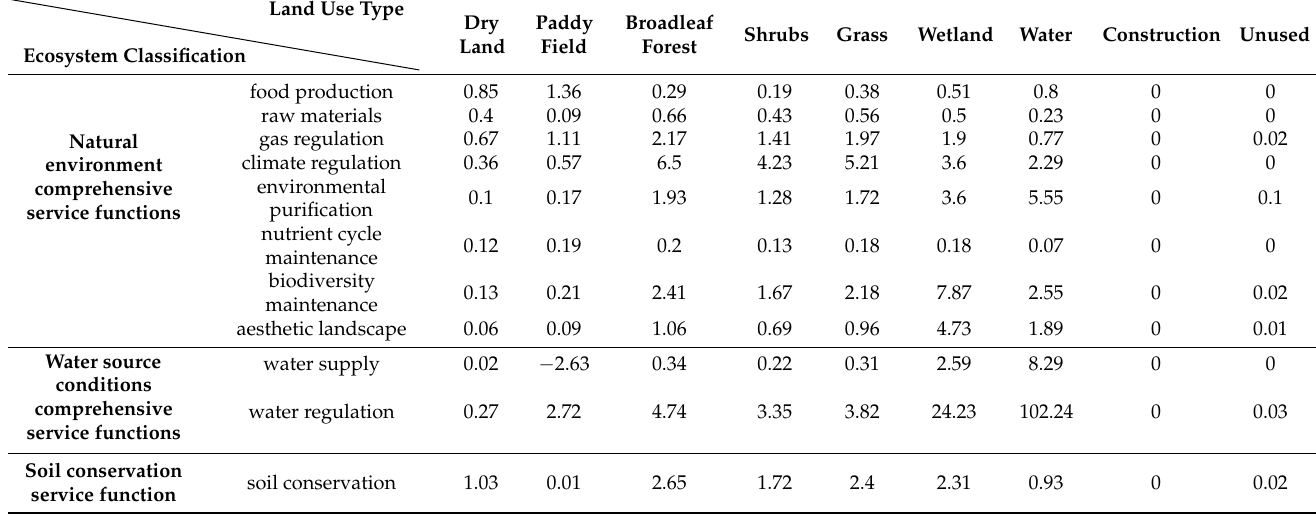
Table 2. Ecosystem services equivalent coefficients